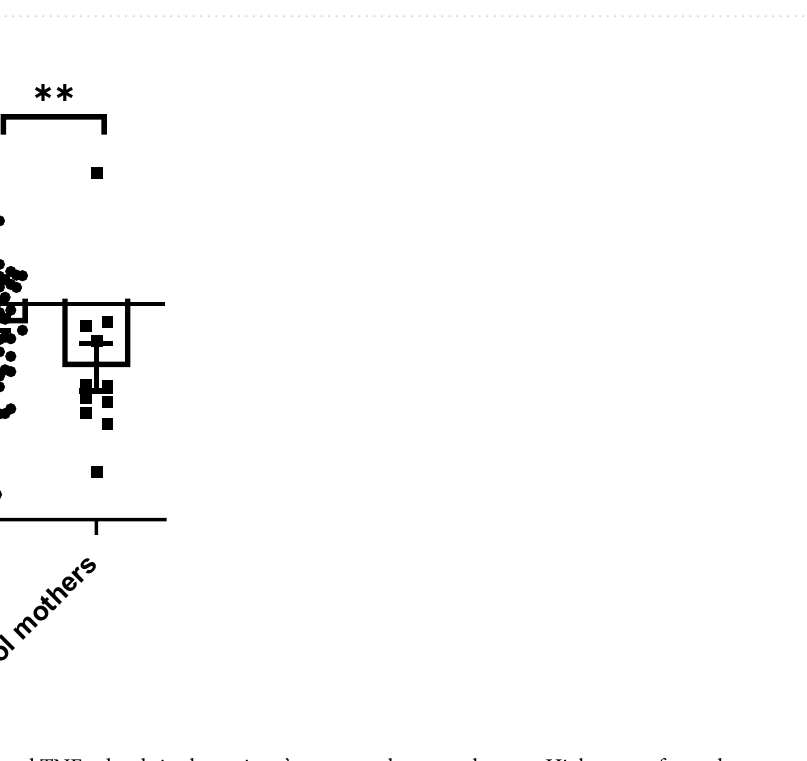
Figure 1. Transformed TNF-α levels in males vs. females. Levels were significantly lower in females than in males in both patients’ parents and control parents (male vs. females: 0.91 ± 0.44 vs 0.70 ± 0.44, F(1, 180) = 24.6, p < 0.001).